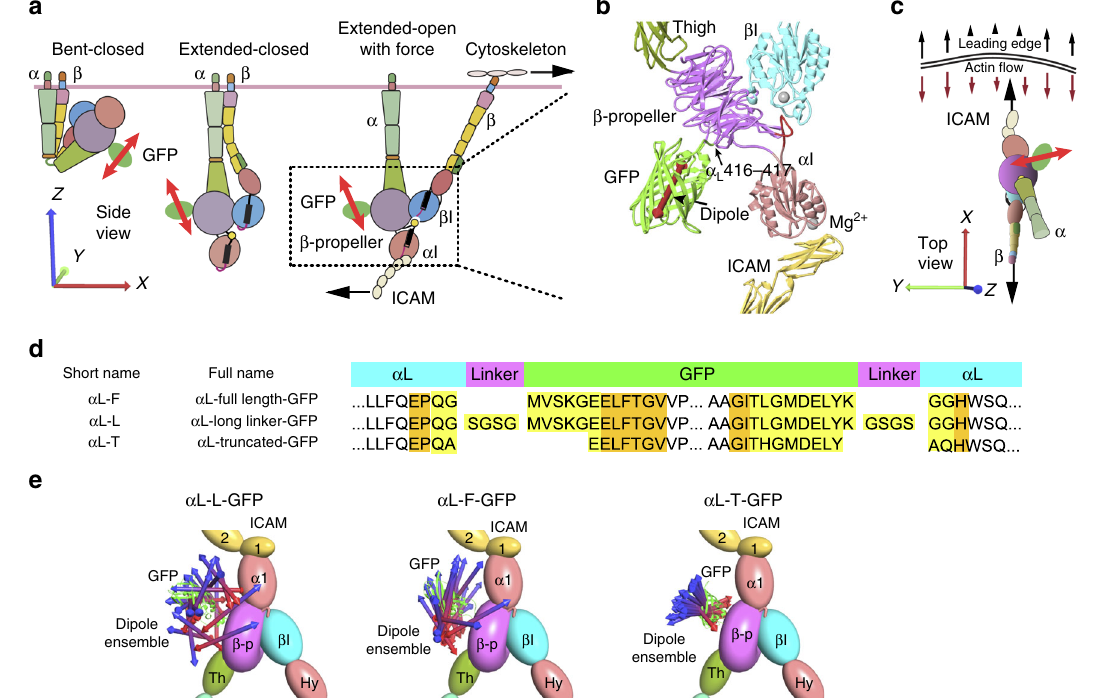
Fig. 1 Integrins, GFP fusions, and modeling GFP and transition dipole orientation with Rosetta. a Three global conformational states of integrins 2 . Cartoons depict each integrin domain and GFP with its transition dipole (red double-headed arrows). b Ribbon diagram of the integrin headpiece of α L-T bound to ICAM-1. The GFP insertion site in the β -propeller domain is arrowed. Dipole is shown in red. c Cartoon as in a of ICAM-engaged, extended-open LFA- 1 showing direction of leading edge motion and actin fl ow. Large arrows show pull on integrin- β by actin and resistance by ICAM-1. Axes shown in a , c are similar to those in the reference state in Fig. 6. d Sequences and boundaries used in GFP-LFA-1 fusions. Highlighted residues were completely modeled by Rosetta to link GFP to the integrin (yellow) or altered in sidechain orientation only to minimize energy (orange). e Orientation of the transition dipole in GFP-LFA-1 fusions. Integrin domains are shown as ellipsoids or torus and GFP is shown in cartoon for 1 ensemble member. GFP transition dipoles are shown as cylinders with cones at each end for 20 representative Rosetta ensemble members, with the asymmetry of GFP referenced by using different colors for the ends of transition dipoles (which themselves have dyad